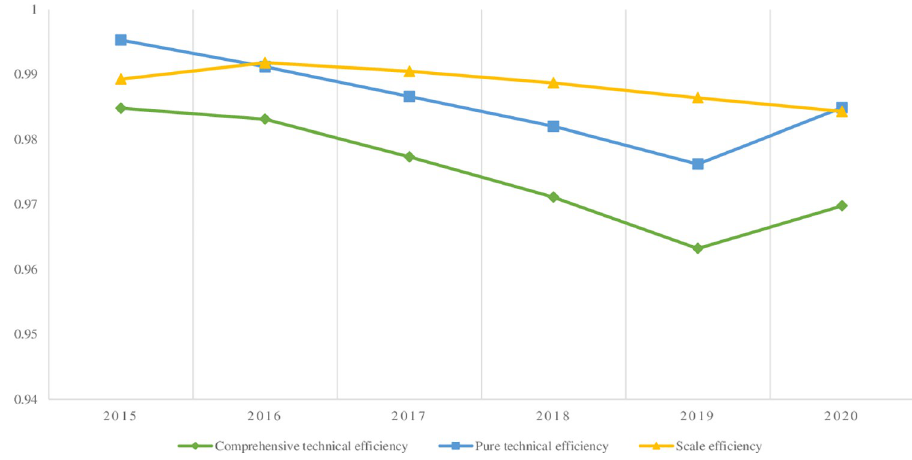
Fig 2. Efficiency values from 2015 to